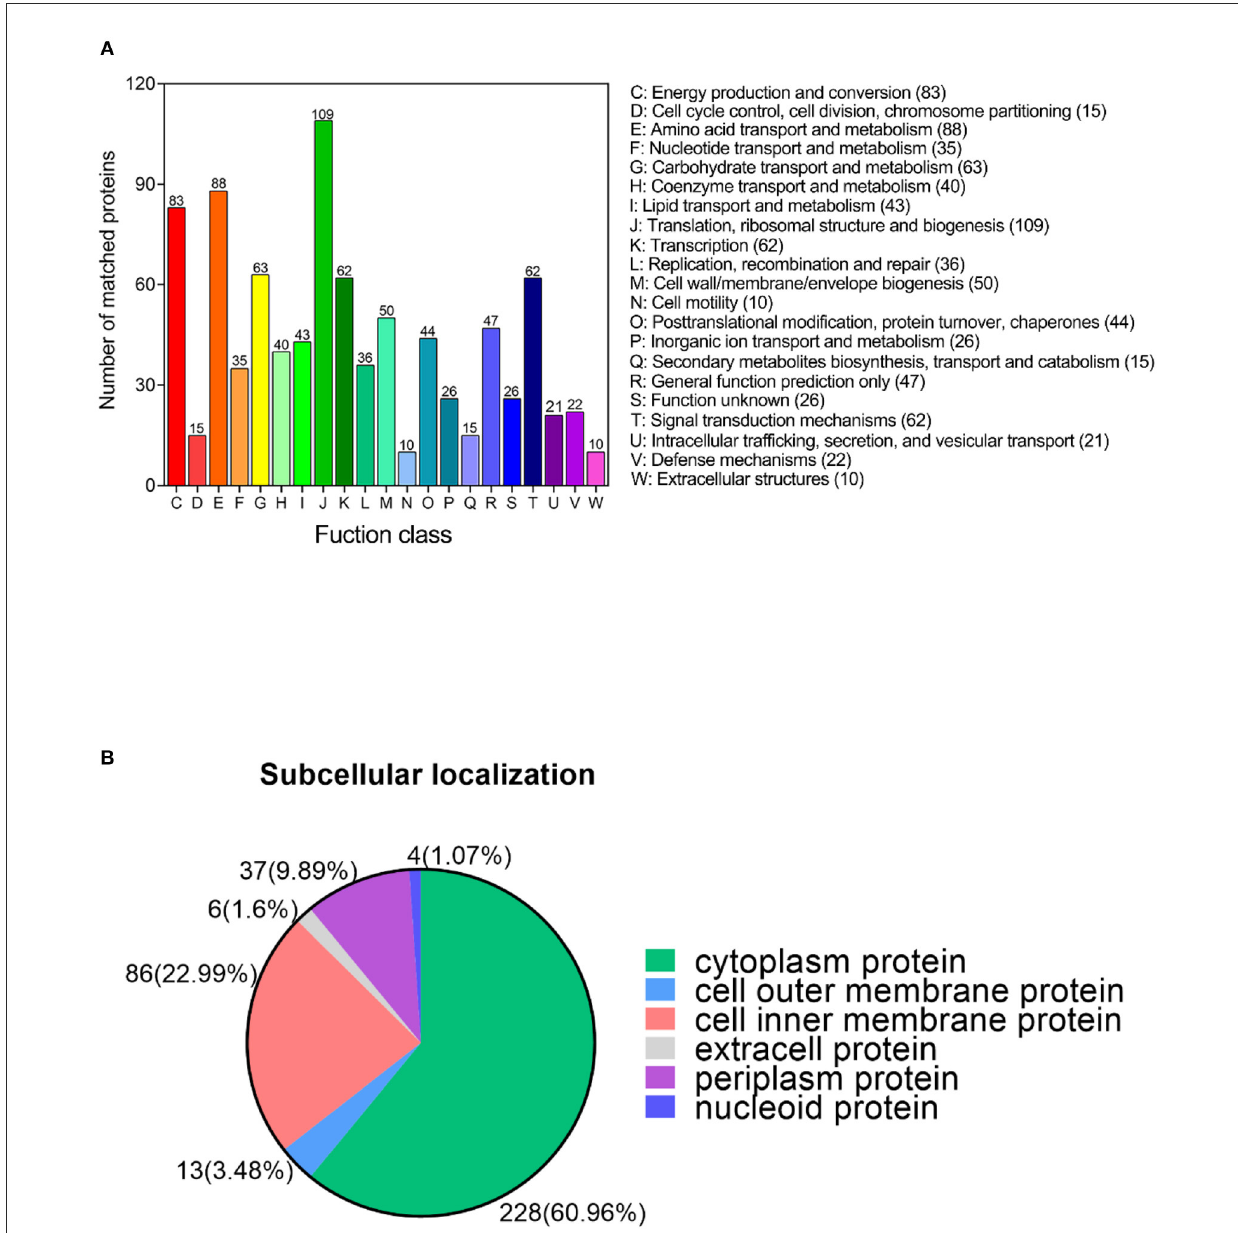
FIGURE4 Functional annotation of the lysine acetylated proteins under bile salt stress in V. alginolyticus . (A) The COG function classification analysis and (B) subcellular localization analysis of the acetylated proteins.